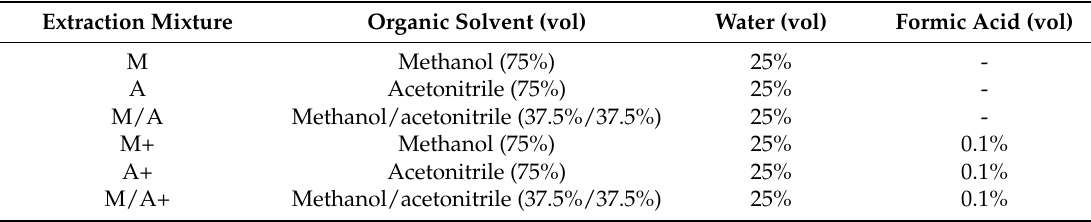
Table 3. Composition of extraction mixtures used in this